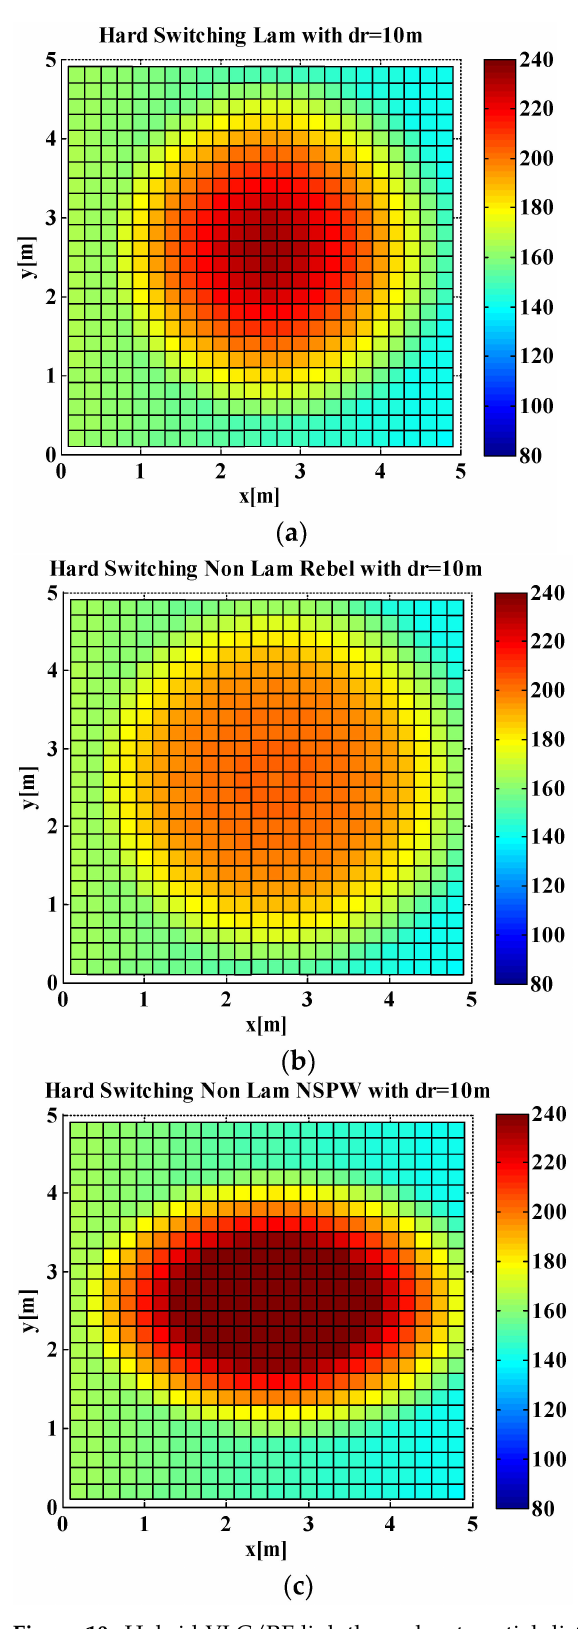
Figure 10. Hybrid VLC/RF link throughput spatial distribution for ( a ) Lambertian optical beam configuration, ( b ) LUXEON Rebel optical beam configuration, and ( c ) asymmetric NSPW optical beam